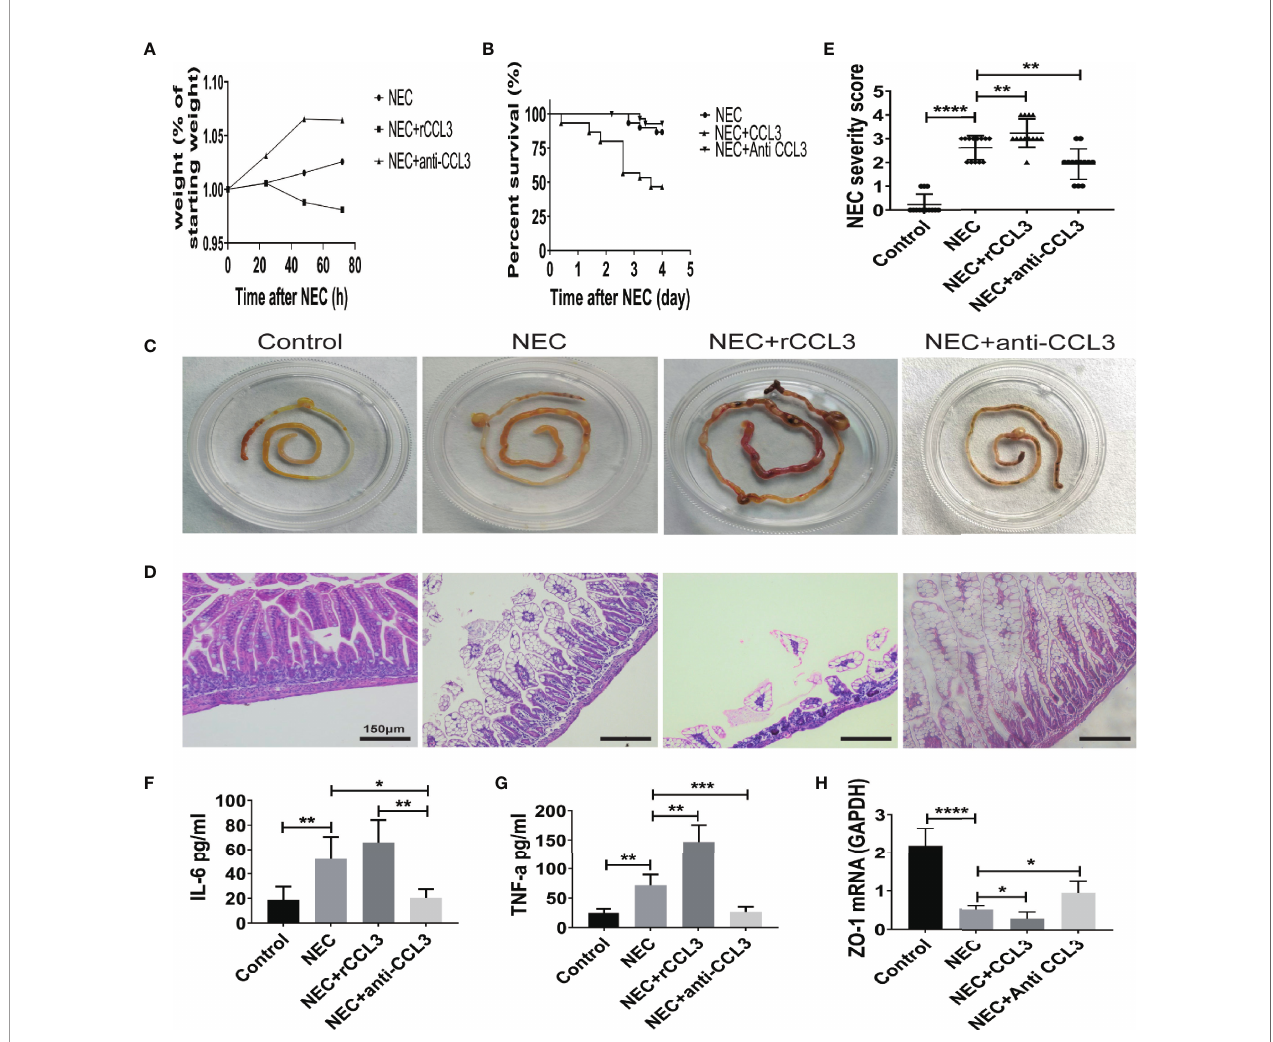
FIGURE 2 | CCL3 exacerbated intestinal damage in the pathogenesis of NEC. (A) Weight changes of surviving pups in the group of NEC (n=9), NEC+rCCL3 (n=8), and NEC+anti-CCL3 (n=10). (B) After modeling, survival was observed in the NEC group, NEC+rCCL3 (50 ng/mL) group, and NEC+ anti-CCL3 (50 ng/mL) group. n=30 for each group. Comparison of survival curves was by Log-rank (Mantel-Cox) test. (C) Macroscopic view of mouse intestinal tissue from Control, NEC, NEC +rCCL3, NEC+anti-CCL3 groups. (D) Representative images of H&E-stained sections from Control, NEC, NEC+rCCL3, NEC+anti-CCL3 groups (Scale Bar =150 m m) (E) Histopathological scores in Control, NEC, and NEC+rCCL3, NEC+anti-CCL3 groups, as shown in (D) . Data are expressed as mean ± SD. **p < 0.01, ****p < 0.0001 when compared between groups (Mann-Whitney U test). (F-G) IL-6, TNF- a expression in the intestinal lysates of Control, NEC, NEC+rCCL3, NEC+anti- CCL3 groups (n-5-8). Data are expressed as mean ± SD. *p < 0.05, **p < 0.01, ***p < 0.001 when compared between groups (Mann-Whitney U test). (H) ZO-1 mRNA expression in the intestinal tissue of Control, NEC, NEC+rCCL3, NEC+anti-CCL3 groups were assessed by RT-PCR (n =4-6/group). Data are expressed as mean ± SD. *p < 0.05, ****p < 0.0001 when compared between groups (Mann-Whitney U